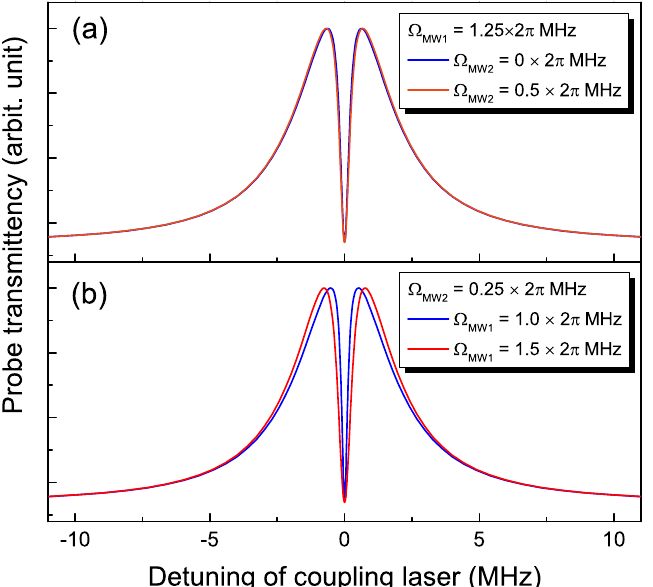
Figure 5. The spectral AT splitting for small change of the microwave field at target signal channel ( a ) and auxiliary channel ( b ). The auxiliary field helps to make the AT splitting gets more obvious for better quantization of the weak target field, but it reduces the sensitivity of the dynamic microwave- optical amplifying gain, which is much smaller than that of the auxiliary field